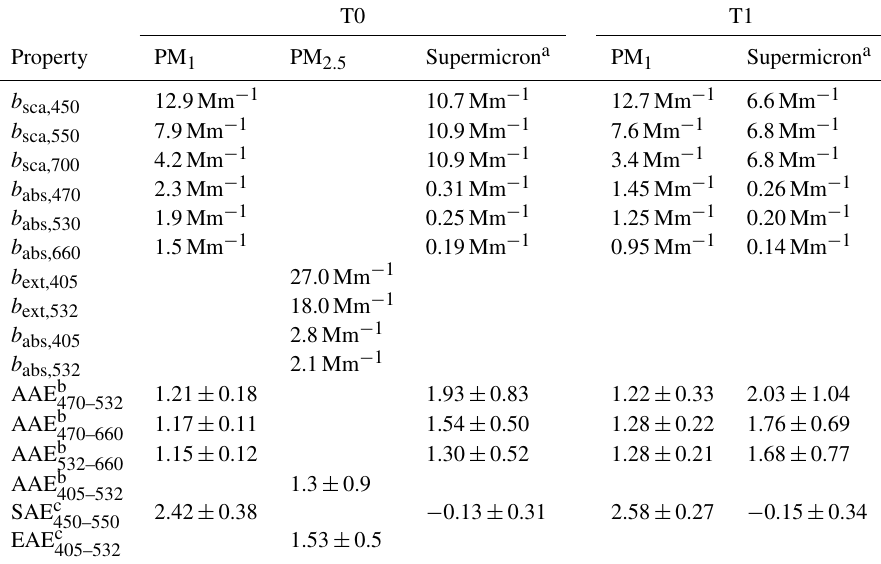
Table 2. Campaign average optical properties at T0 and T1 for submicron and supermicron particles.